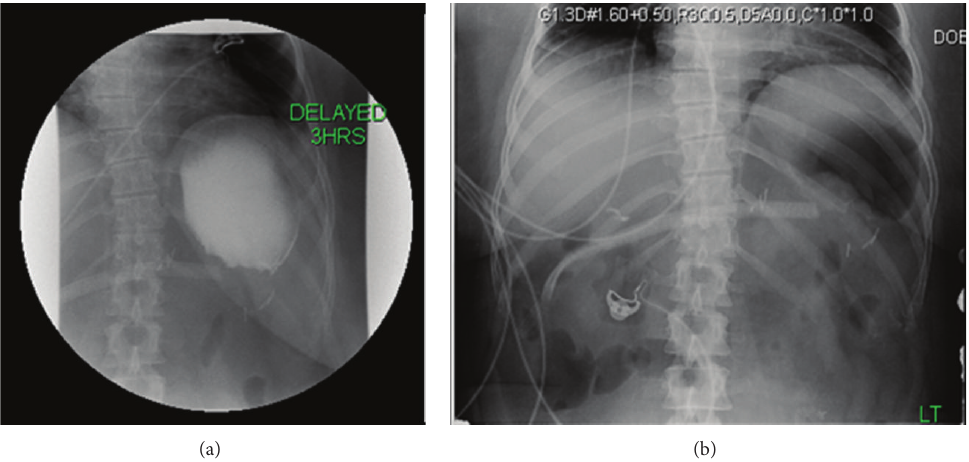
Figure 5: Contrast seen flowing from distal esophagus into remaining stomach without leakage from the anastomotic